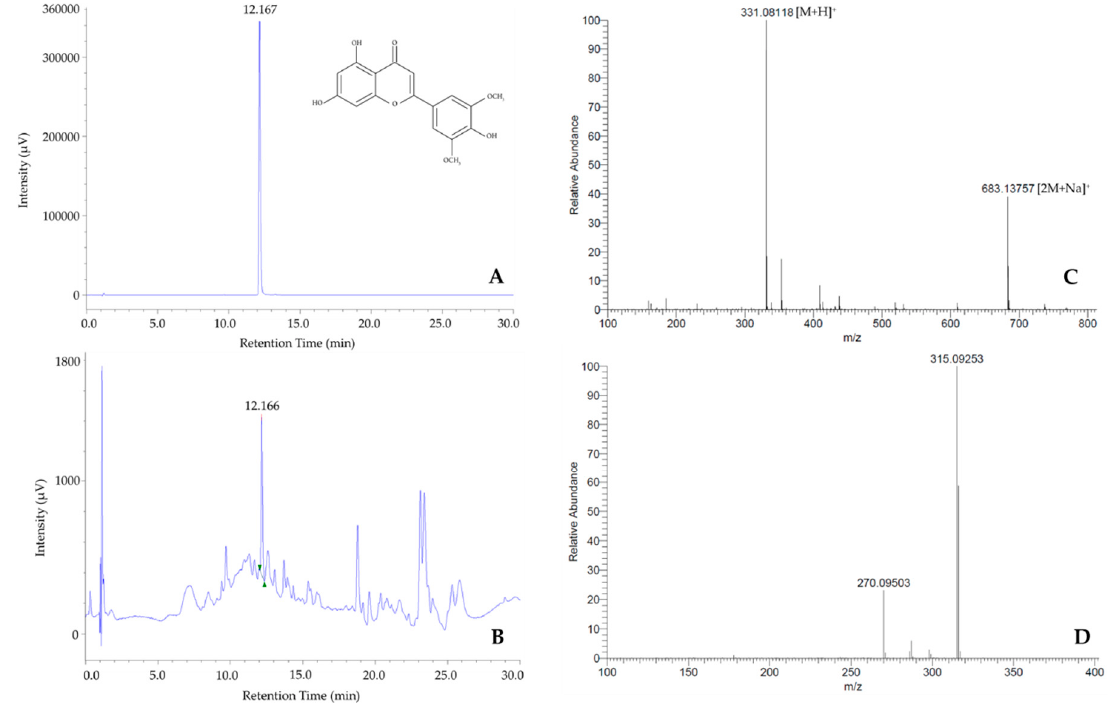
Figure 1. HPLC chromatograms of isolated tricin ( A ) and detected tricin in rice grain extract ( B ); Mass spectrum ( C ) and MS-MS product ions for m / z 331 of isolated tricin ( D ) by FIA-ESI. Table 2. Antioxidant activities of momilactones A, B, and tricin in terms of 2,2’-azino-bis (ABTS) and β -carotene bleaching assays.